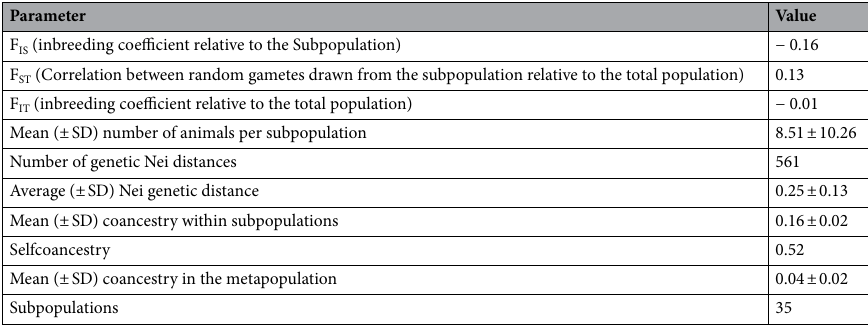
Table 5. Wright’s Fixation statistics and zoo’s genetic distancing